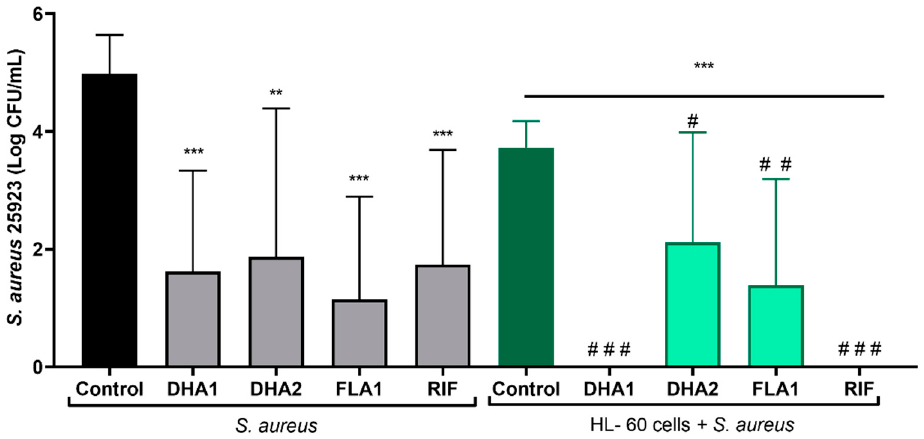
Figure 6. Viable counts of adhered S. aureus ATCC 25923 on LDPE tubes exposed to di ff erent antimicrobial compounds (tested at 50 µ M) after 24 h of incubation. The gray bars show the attached viable bacteria when exposed just to the antimicrobial compounds, while the green bars show the results when S. aureus strains were cocultured with HL-60 cells. “*” indicates statistical di ff erences with the control in monoculture, while “#” represents statistical di ff erences with the control in cocultured controls with Welch’s unpaired t -test ( ** p < 0.01; *** p < 0.001) / ( # p < 0.05; ## p < 0.01; ### p < 0.001). Values are means and SD of three independent experiments.